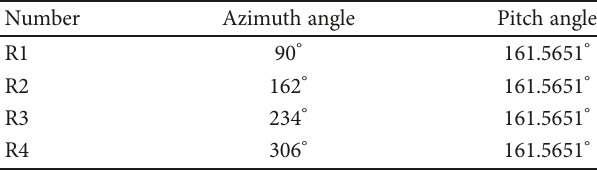
Table 2: Parameter settings of receiving antennas in HFSS